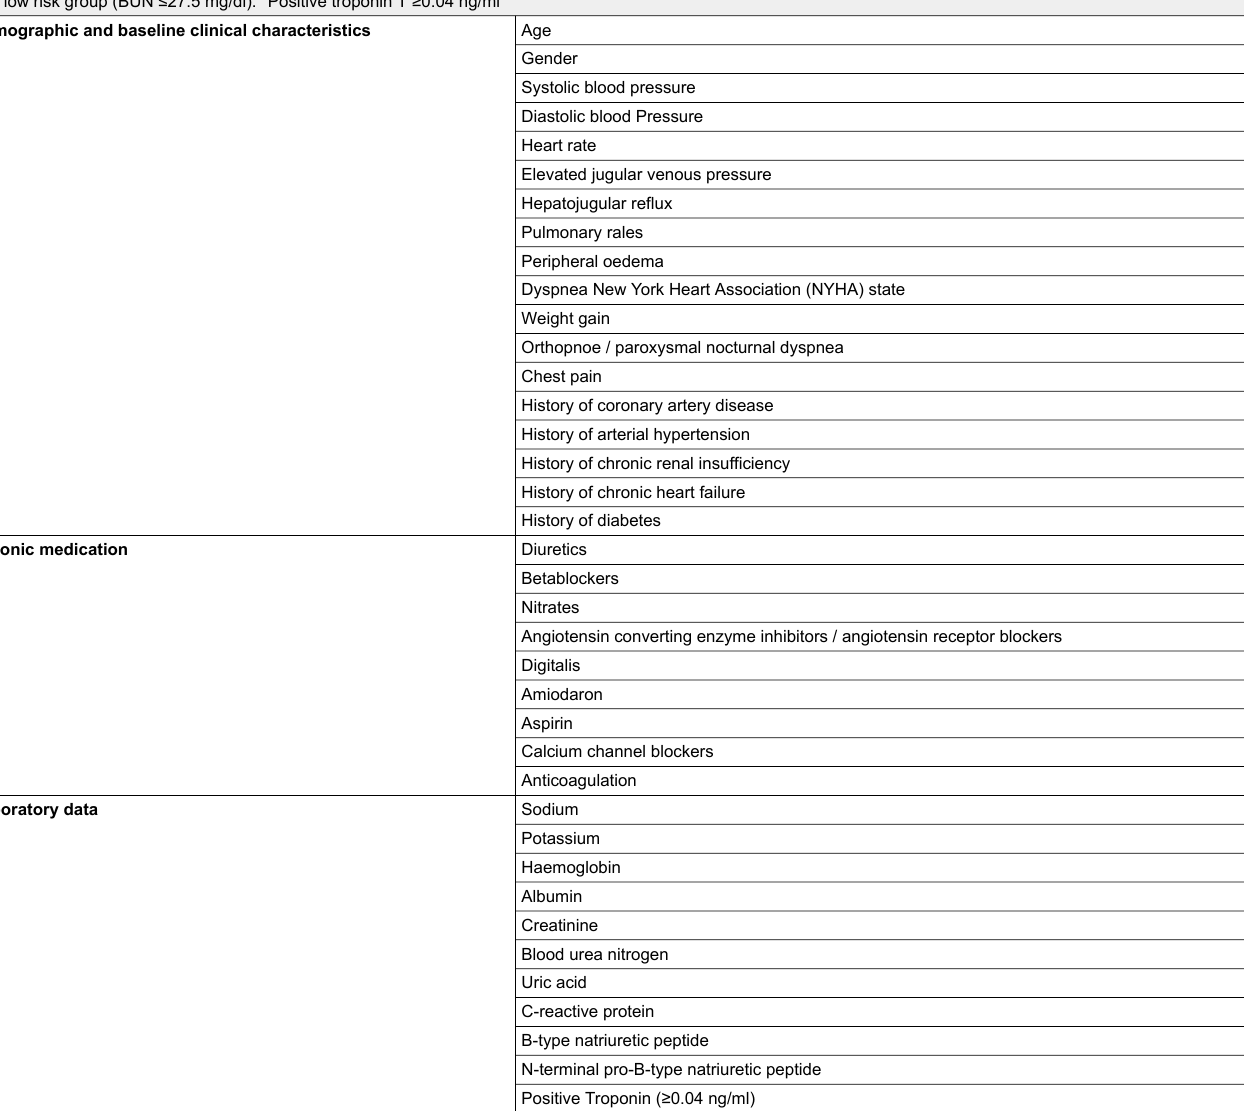
Table 2: Variables tested for their predictive potential for 1-year mortality. ¹ = paroxysmal nocturnal dyspnea, ² B-type natriuretic peptide, ³ N-terminal pro-B-type natriuretic peptide; Data are presented as median (interquartile range), number of patients (%) or mean ± SD. Definition of risk groups: high risk group (BUN >27.5 mg/dl and age >86 years), intermediate risk group (BUN <27.5 mg/dl and age ≤86 years) and low risk group (BUN ≤27.5 mg/dl). *Positive troponin T ≥0.04